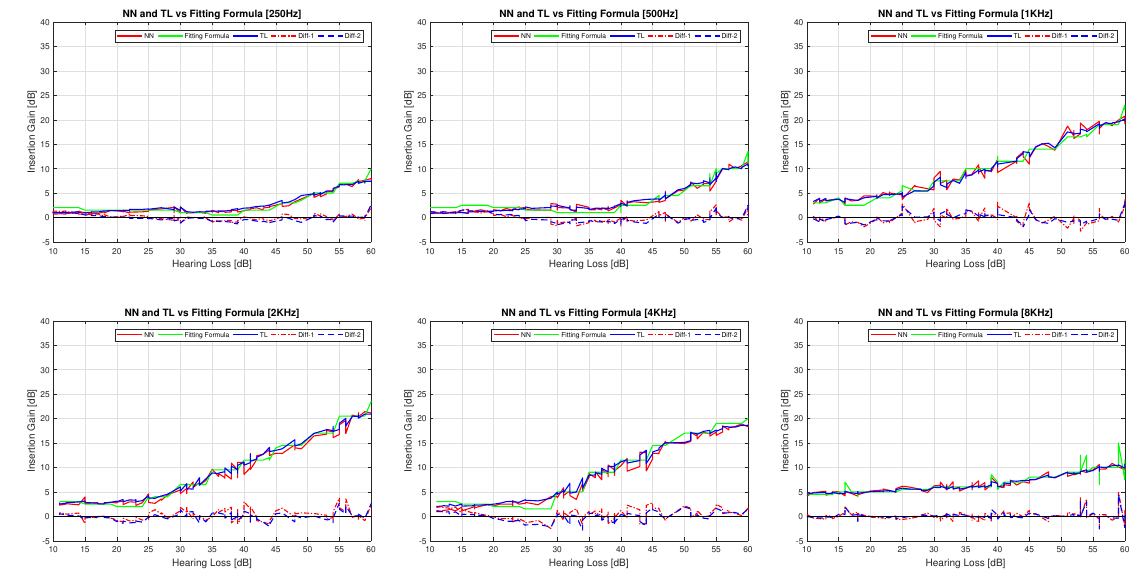
Figure 9. NAL-NL1: Performance comparison for NN and TL vs. fitting formula for the 80 dB input level. Comparisons are made for 250 Hz, 500 Hz, 1 KHz, 2 KHz, 4 KHz, and 8 KHz frequencies from top left to right to bottom left to